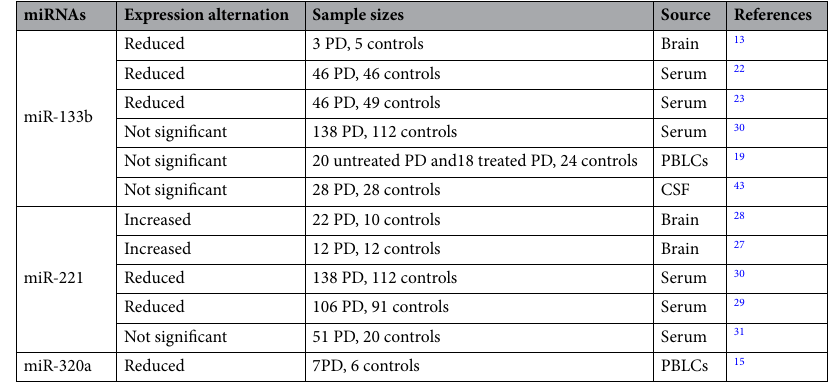
Table 6. Summary of three miRNA (miR-133b, miR-221 and miR-320a) alterations in Parkinson’s disease compared to controls from previous studies. PBLCs, peripheral blood lymphocytes; CSF, cerebrospinal fluid; PD, Parkinson’s